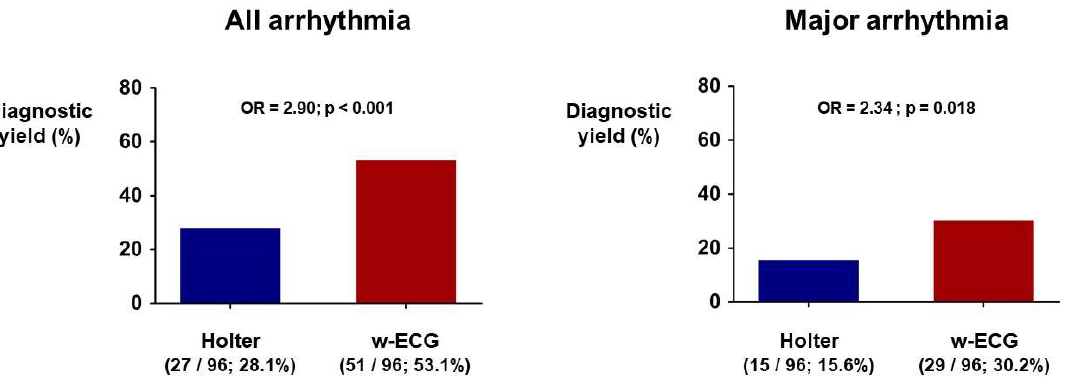
Figure 5. Diagnostic yield of Holter monitoring versus the w-ECG. The w-ECG was superior to Holter monitoring at detecting all arrhythmias and major arrhythmias. OR: odds ratio; w-ECG: watch-type ECG device.